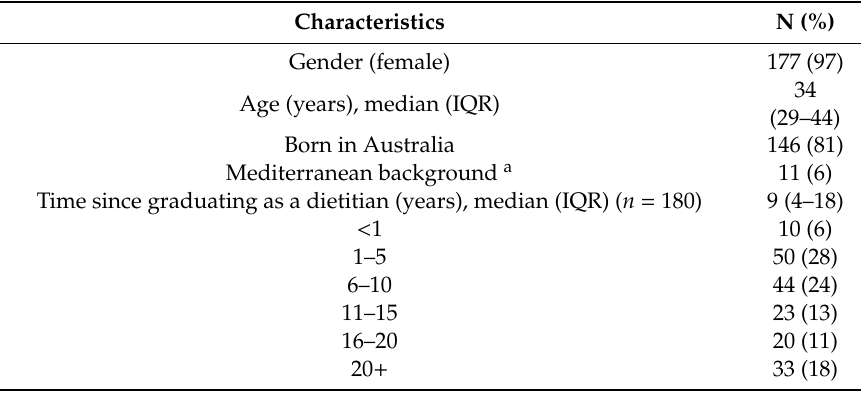
Table 1. Characteristics of dietitian participants ( n =